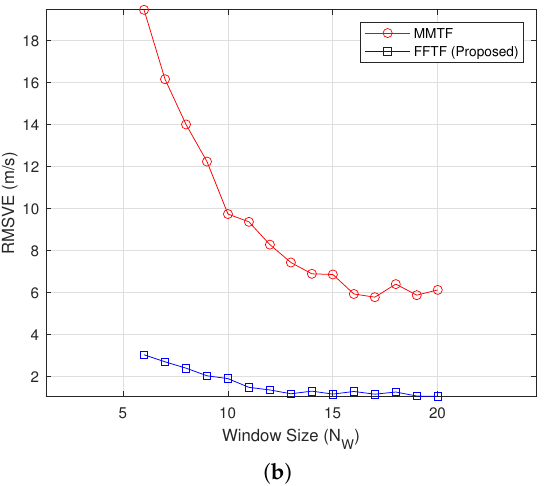
Figure 2. Simulation results under the long-range mode ( D r = 100 m): ( a ) root-mean-square position error (RMSPE), ( b ) root-mean-square velocity error (RMSVE).